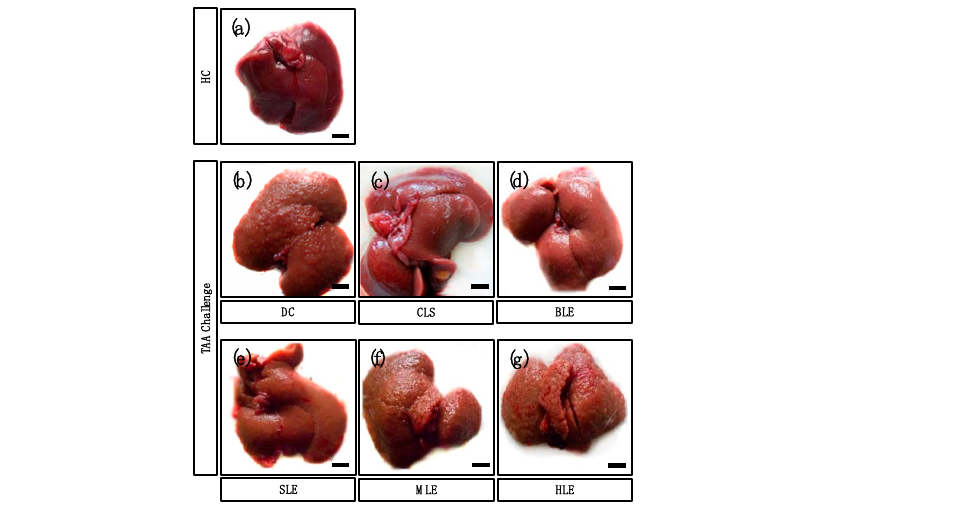
Figure 3. Aqueous extracts (CLS, BLE and SLE) demonstrated more potency to protect the liver against TAA challenge. ( a ) HC livers showed a normal appearance with a smooth surface. ( b ) Nu- merous nodules of various sizes can be seen on the liver surface of DC. ( c ) Livers treated with CLS showed a smooth surface. ( d ) Small nodules can be seen on the surfaces of livers treated with BLE and ( e ) SLE. ( f , g ) Nodules of variable sizes were present on the surfaces of livers treated with MLE and HLE. Bar = 10 mm.